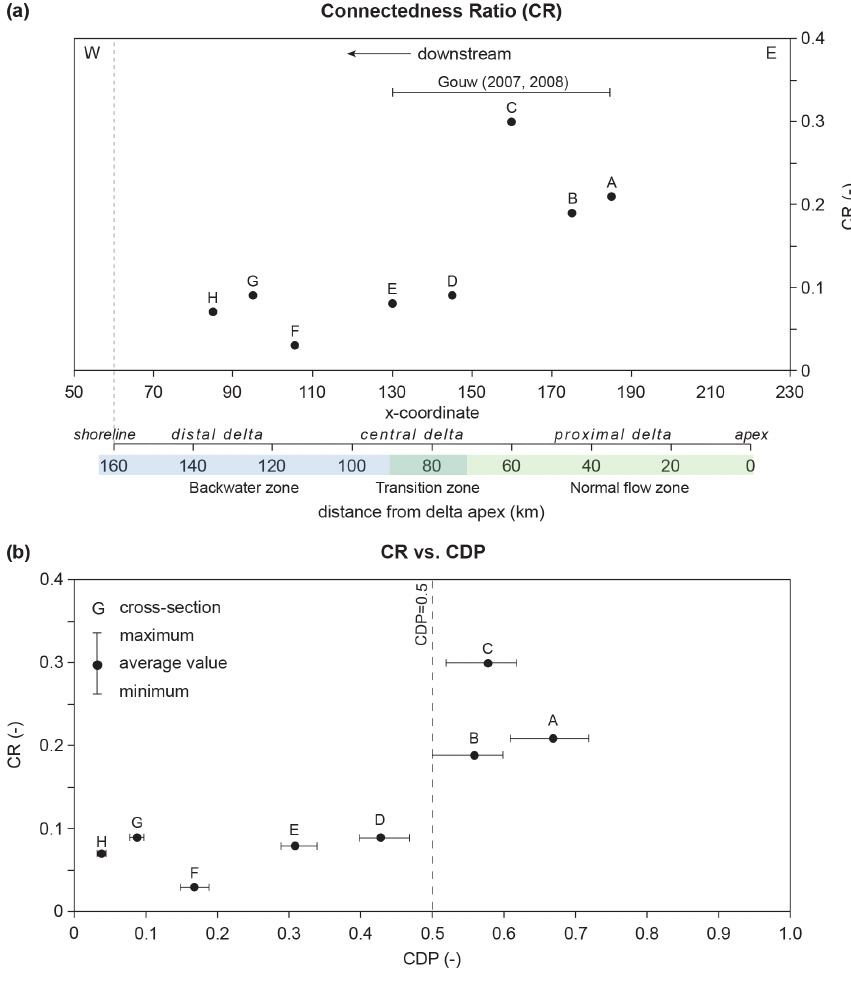
Figure 8. (a) CR as established for the cross sections and (b) CR plotted against CDP. CR decreases in a downstream direction. The high value for cross-section C is due to the presence of an exceptionally large complex channel-belt sand body. CR is significantly higher when CDP exceeds 0.5 (cf. Gouw, 2008). Data for cross-sections A–E are from Gouw (2007a,